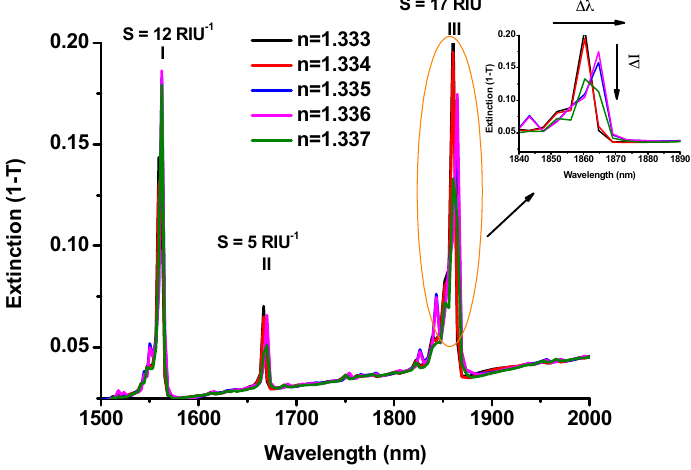
Figure 5. Extinction spectrum of a hybrid nanostructure with cubic NPs side at L/P = 0.17.